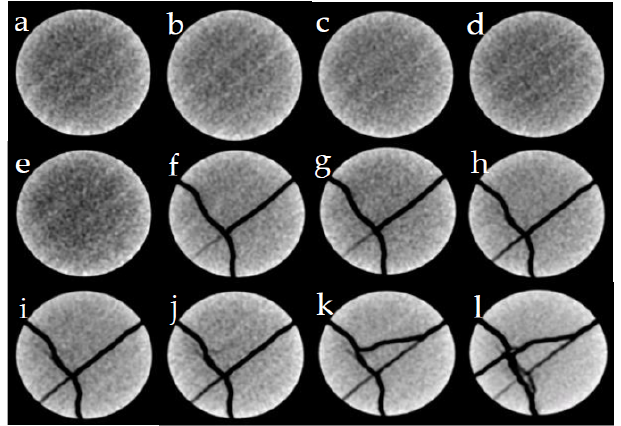
Figure 4. CT image of the third scan section: ( a ) σ = 0.00 MPa; ( b ) σ = 8.14 MPa; ( c ) σ = 10.30 MPa; ( d ) σ = 14.02 MPa; ( e ) σ = 16.71 MPa; ( f ) σ = 18.85 MPa; ( g ) σ = 19.09 MPa; ( h ) σ = 19.93 MPa; ( i ) σ = 20.59 MPa; ( j ) σ = 21.45 MPa; ( k ) σ = 23.05 MPa; ( l ) σ = 25.88 MPa.